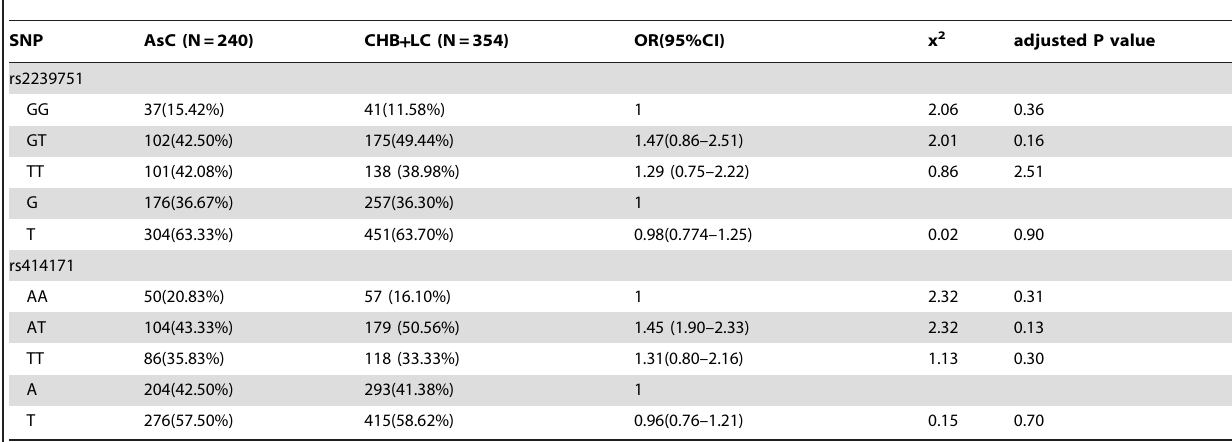
Table 4. Genotype and allelic distribution for CISH gene polymorphisms when AsC group was compared to CHB + LC group.